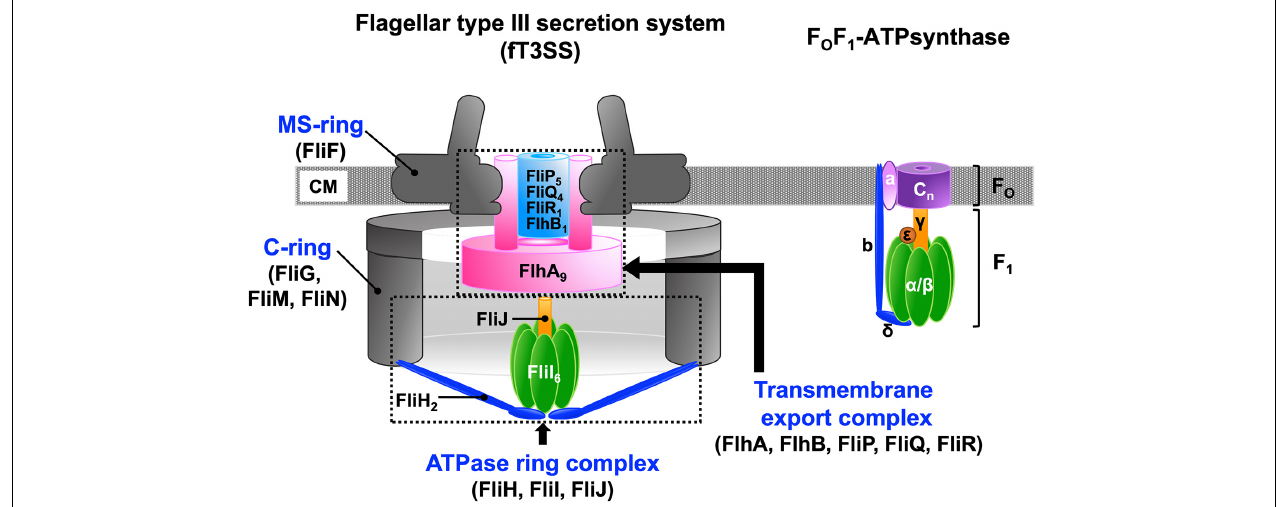
FIGURE 1 | Schematic diagrams of the flagellar type III export apparatus and F O F ATP synthase. The flagellar type III secretion system (fT3SS) is composed of five membrane proteins, FlhA, FlhB, FliP, FliQ, and FliR and three cytoplasmic proteins, FliH, FliI, and FliJ. FlhA, FlhB, FliP, FliQ and FliR assembles into a transmembrane export complex within the MS-ring of the basal body of the flagellum. FliH, FliI, and FliJ form a cytoplasmic ATPase ring. The FliI 6 -FliJ 1 ring complex is structurally similar to the α 3 β 3 γ 1 ring complex of the F O F 1 ATP synthase. The N-terminal and C-terminal domains of FliH structurally are similar in structure to the b and δ subunits, respectively, of the F O F 1 ATP synthase. The FliH dimer acts as a peripheral stalk that anchors the FliI 6 -FliJ ring complex to the base of the flagellum in a similar manner as the b and δ subunits of the F O F1 ATP synthase connect the α 3 β 3 γ ring complex to membrane-embedded F O . The stoichiometry of the c-ring varies dramatically from c